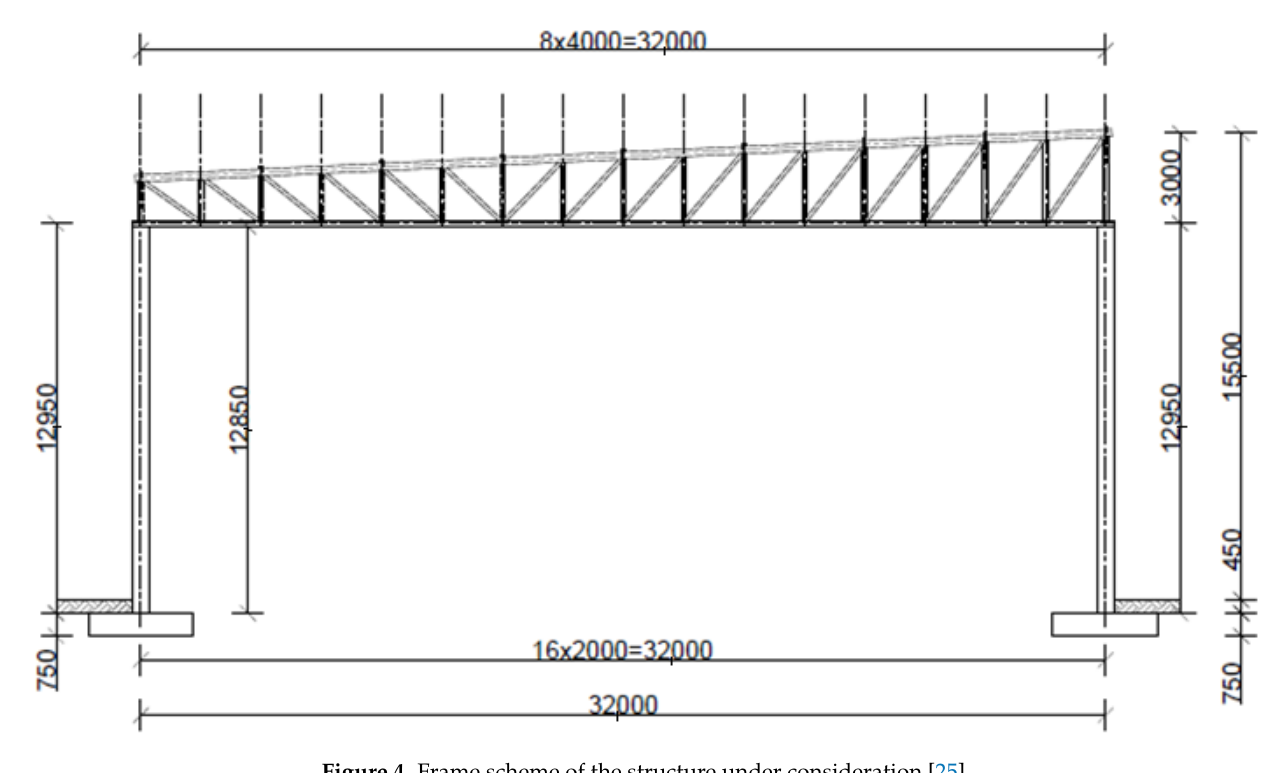
Figure 4. Frame scheme of the structure under consideration [25]. Table 2 summarizes the steel structure data relevant to the analysis. Table 2. Data of the steel hall under